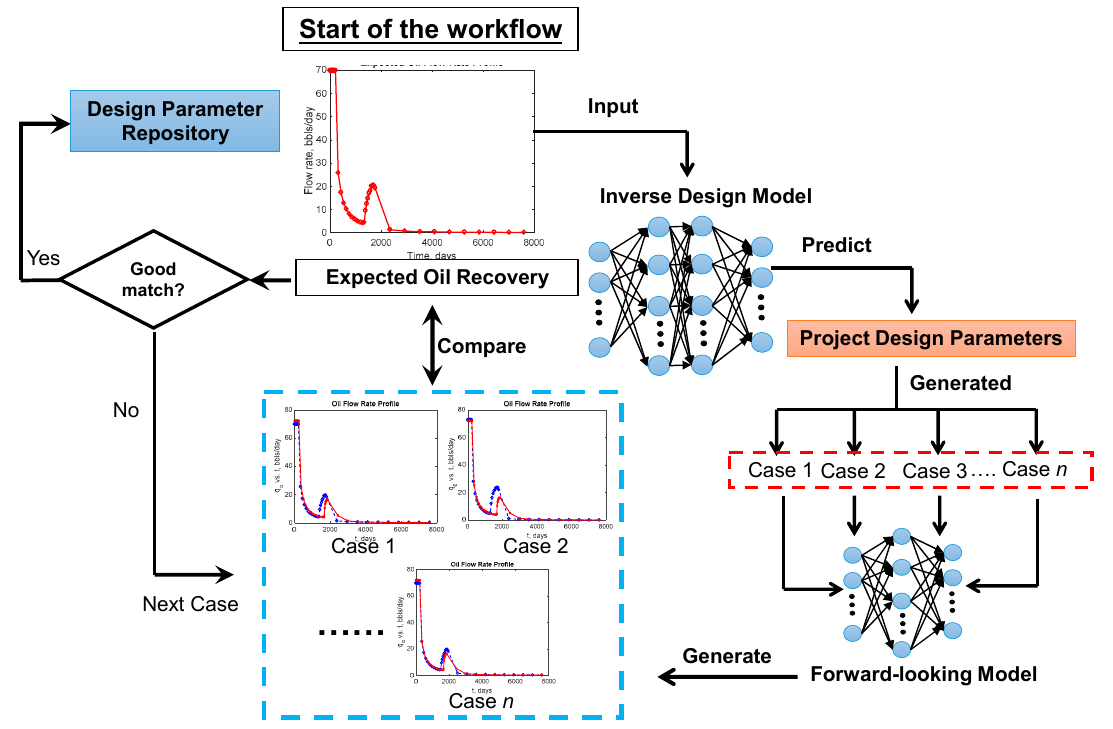
Figure 5. Inverse project design workflow.